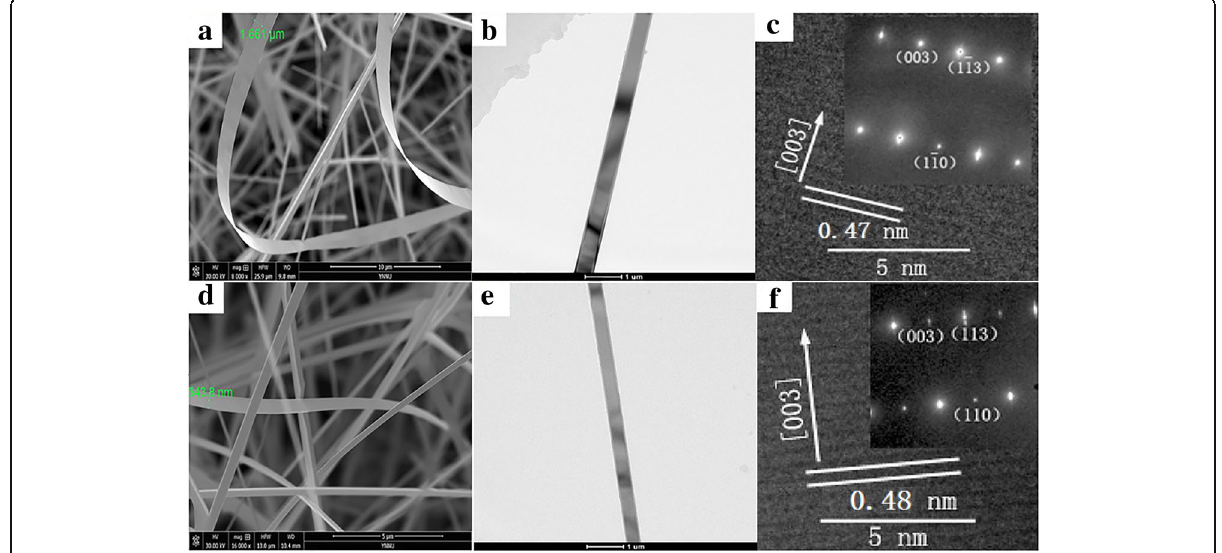
Fig. 3 The morphology images of Eu-SnO 2 NB and SnO 2 NB. a SEM, b TEM, and c HRTEM images of Eu-SnO 2 NB; d SEM, e TEM, and f HRTEM images of